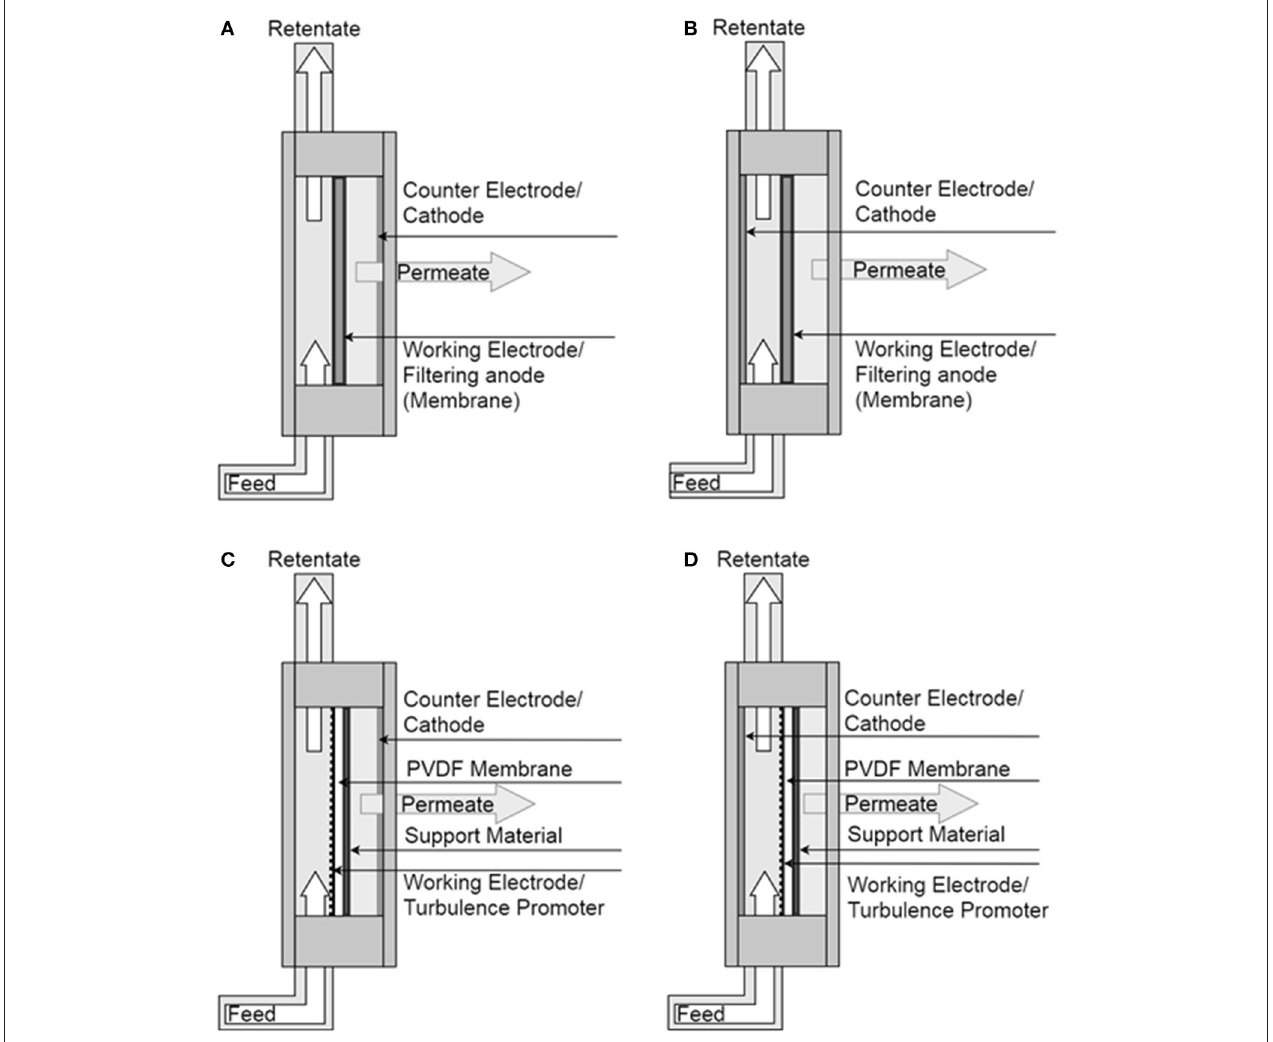
FIGURE 2 | Illustration of filter cassette for various experimental configurations; filtering anode consists of stainless steel filter plate and cathode located on the permeate side (A) and on the retentate side (B) ; hybrid anode, in which a PVDF membrane combined with stainless steel mesh and cathode located on the permeate side (C) and on the retentate side (D)